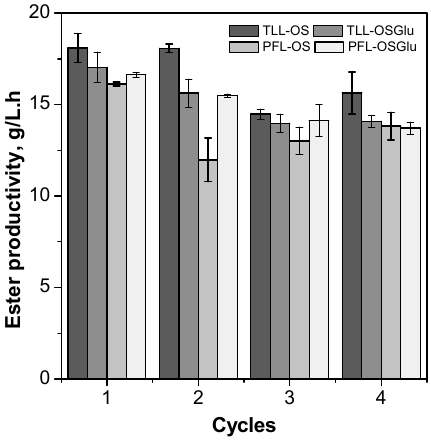
Figure 5. Operational stability of TLL-OS, PFL-OS, TLL-OSGlu and PFL-OSGlu in the synthesis of fructose oleate at 35 ◦ C in tert- butyl alcohol containing 1% v / v of water, using a fructose/oleic acid molar ratio of 1:5, 8.4 IU/mL solvent ( p -NPB activity) for 30 min of reaction.